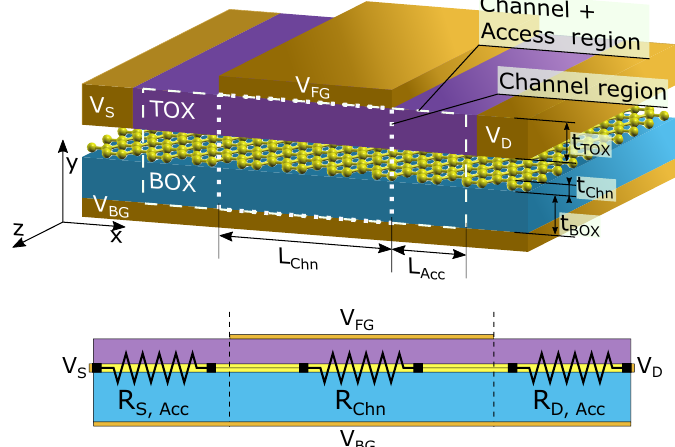
Figure 1. Schematic of the simulated GFET and the characteristic resistances of the device. The dashed and dotted rectangles indicate the regions used for the different simulations. While the dotted rectangle only encompasses the channel region, the dashed one includes the access